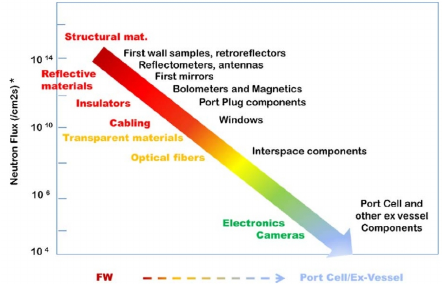
Figure 16. Neutron flux over the different diagnostic systems. Reprinted with permission from Ref. [107]. Credit c (cid:13) Elsevier,